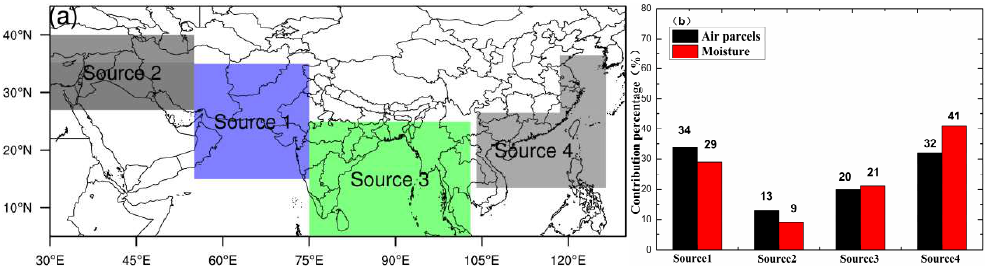
Figure 11. Moisture source distribution division ( a ) and the contribution percentages (units: %) of moisture and air parcels transport from sources ( b ).